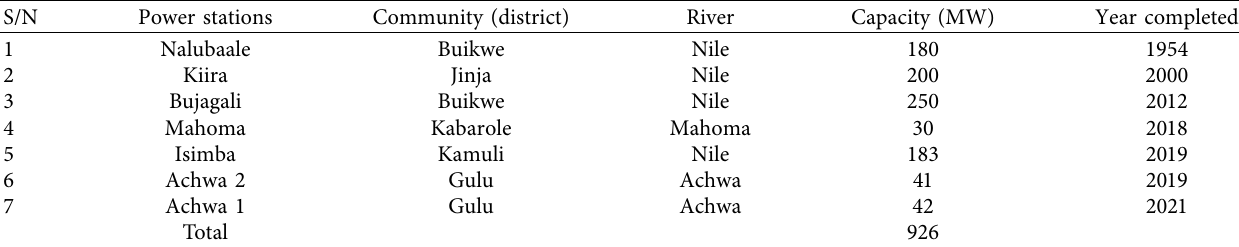
Table 3: Operational large hydropower plants.